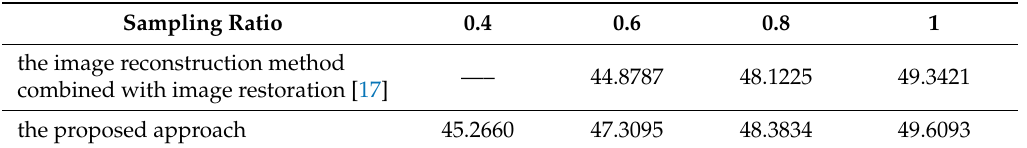
Figure 9. The 1st row shows the image reconstruction method combined with image restoration [12] (left) and the proposed approach (right) for 80% of measurements, respectively. The 2nd row shows the results of the image reconstruction method combined with image restoration [12] (left) and the proposed approach (right) for 60% of measurements, respectively. Table 4. PSNR contrast among the image reconstruction method combined with image restoration [17] and the proposed